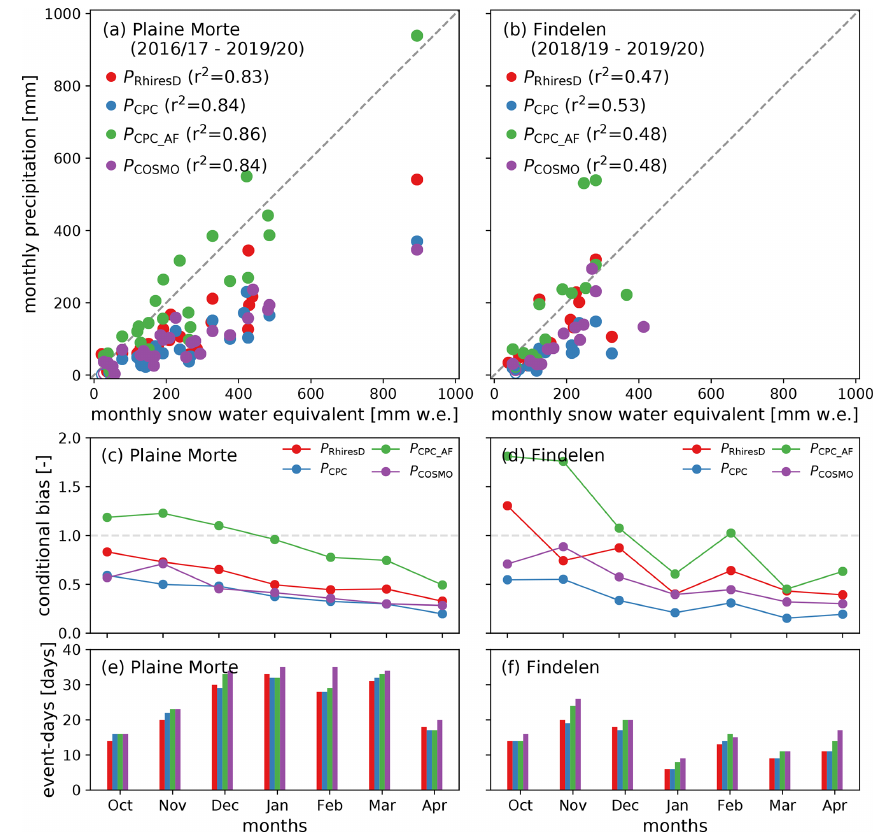
Figure 3. Panels (a) and (b) show the monthly precipitation and SWE totals on Plaine Morte and Findelen, respectively. Panels (c) and (d) show the conditional bias grouped for the month over four and two winter season on Plaine Morte and Findelen, respectively. The four (two) year sum of event-days of the given month are presented in (e) and (f) for Plaine Morte and Findelen, respectively. In (c) and (d) values below (above) one show an underestimation (overestimation) of precipitation amounts with respect to